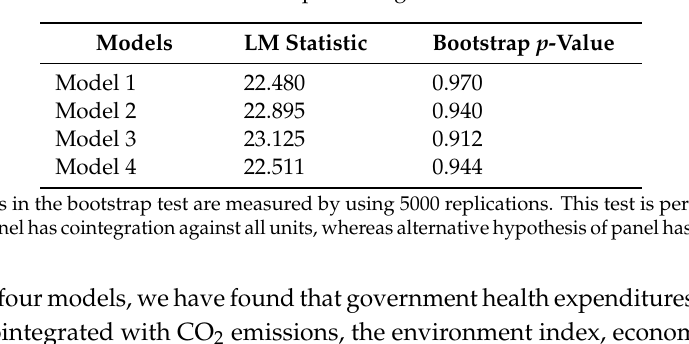
Table 5. LM Bootstrap Co-integration Test